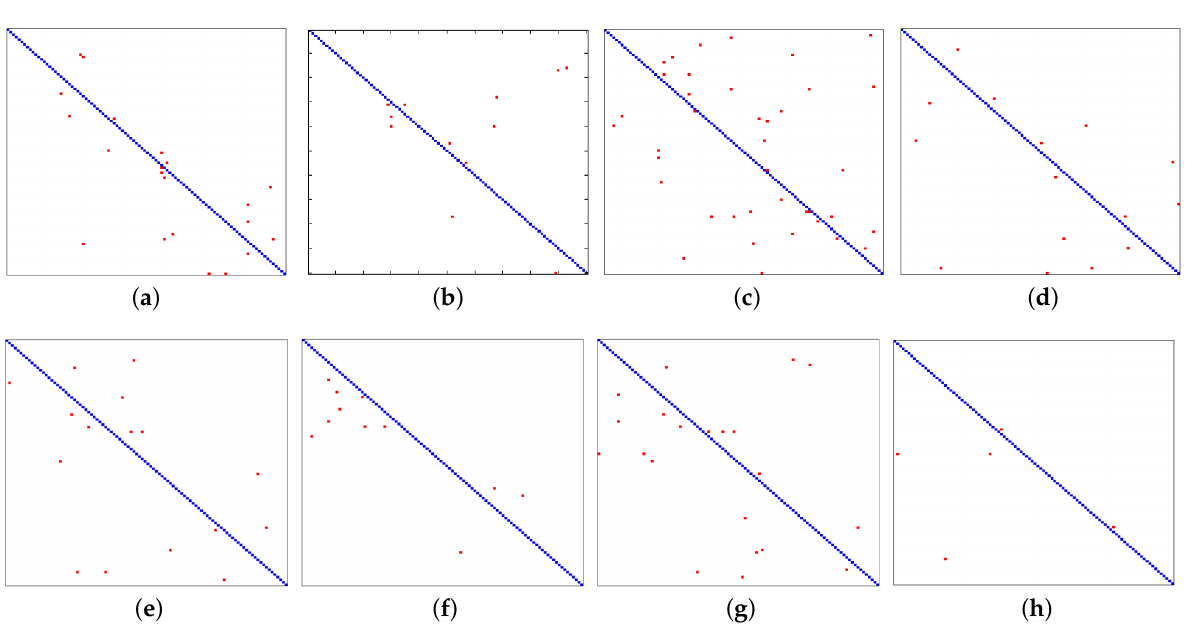
Figure 8. Patterns of confusion on AR dataset. ( a ) SRC. ( b ) CRC. ( c ) ScELM. ( d ) PSD. ( e ) LISTA. ( f ) LAMP. ( g ) LVAMP. ( h )